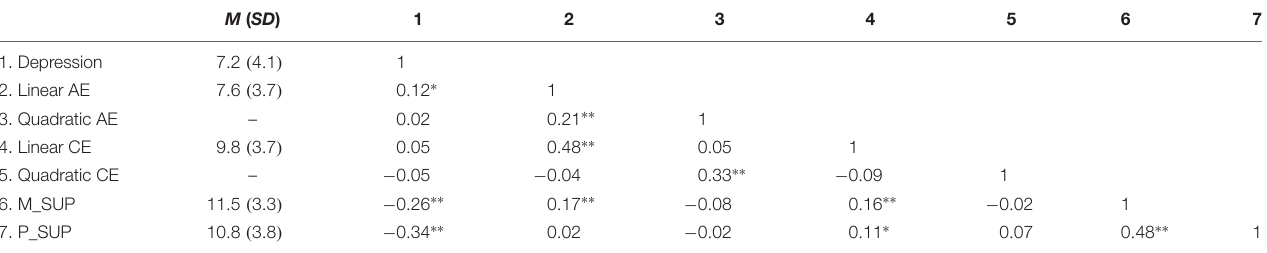
TABLE 1 | Descriptive statistics and bivariate correlations among study variables.